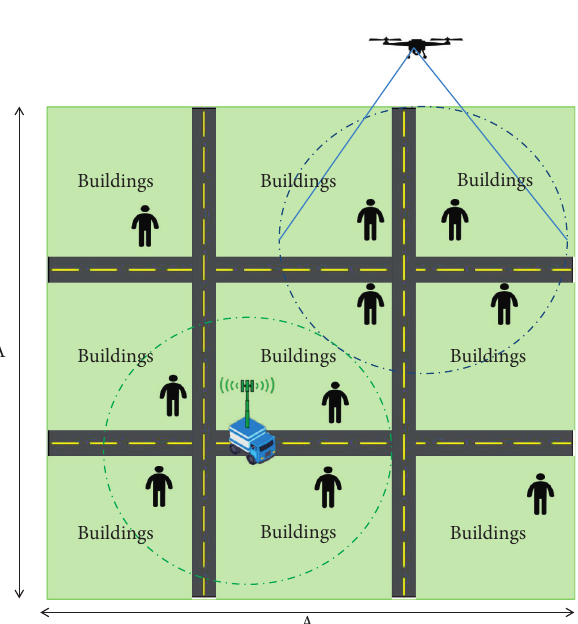
Figure 1: The proposed system model. The area (A x A) is covered by a CoW assisted by a